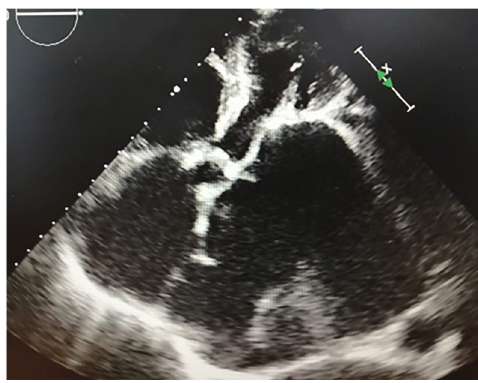
The aorta and the trunk of the pulmonary artery were cut off transversely in order to mobilization of the LA. The dilated LA wall was excised while preserving the physiological anatomy Figure 2 - Echo. Perioperative period.